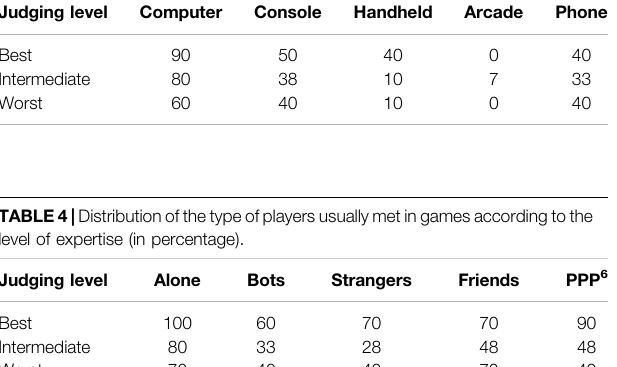
TABLE 3 | Distribution of the devices usually used to play according to the level of expertise (in percentage). Judging level